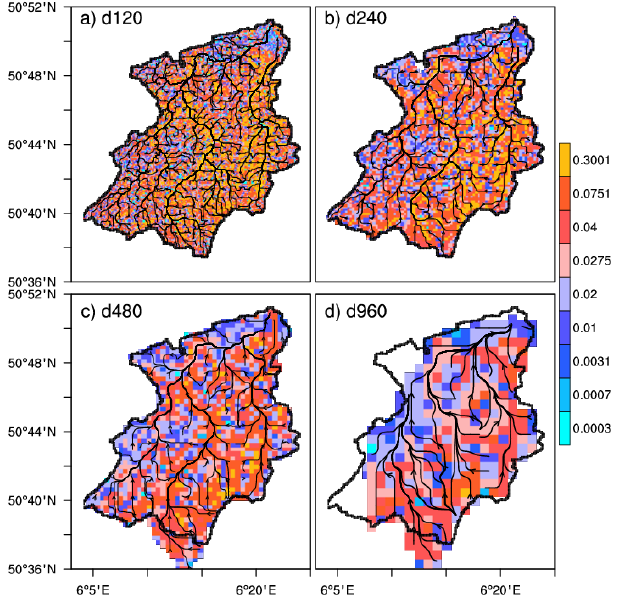
Figure 3. (a–d) Streamlines resulting from D4 flow directions along with slopes for the four grid resolutions. The black solid outline represents the catchment boundary at 120m resolution. Figure 4. (a) Time series of unsaturated storage per unit catch-